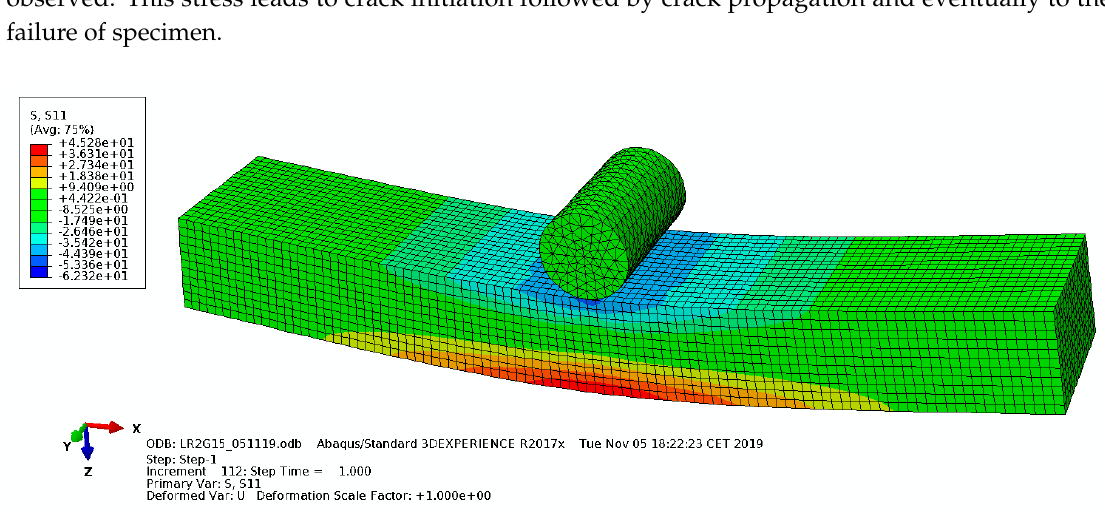
Figure 6. Comparison of the experimental results and FEM analyses. 3.4. Determination of the Fracture Toughness and Toughening Mechanisms Identification by Means of SEM Due to the manufacturing and post-processing methods or during service, cracks or defects may occur in the materials. Also, some discontinuities or particles with undesired geometries inside the microstructure can behave as cracks, and they can be responsible for the fracture of materials. Therefore, it is not always the most reliable way to design critical aeronautical part, such as the brackets in the wings, by considering the yield strength of the manufactured composites, since fractures may occur in the presence of cracks at smaller loads. For this reason, using fracture